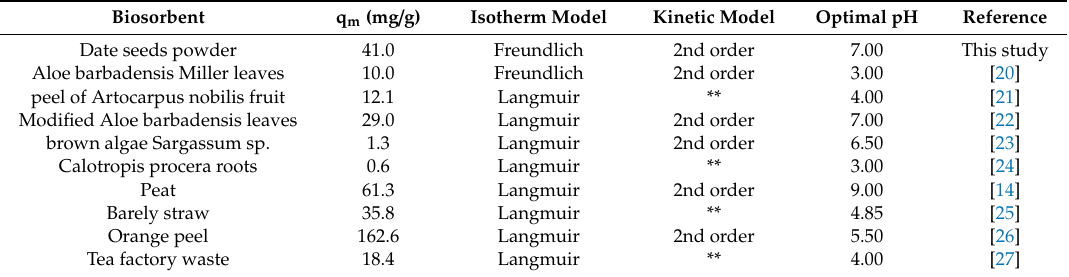
Table 5. Comparison of the DSP with other biosorbents used for the removal of Ni(II)